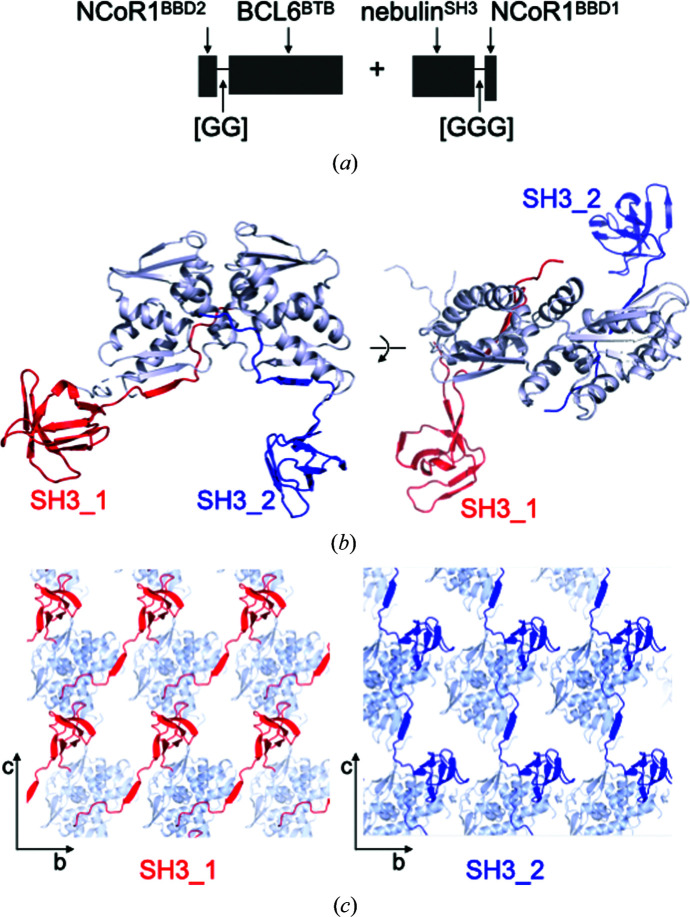
The BCL6 BTB domain as a crystallization chaperone. (a) Schematic representation of fusion proteins. (b) Structure of the NCoR1BBD2(link)-BCL6BTB/nebulinSH3-NCoR1BBD1 complex. BCL6 BTB dimers are shown in white/blue and NCoR1BBD1-nebulinSH3 sequences in red and dark blue. (c) Crystal packing of the two SH3 domains.